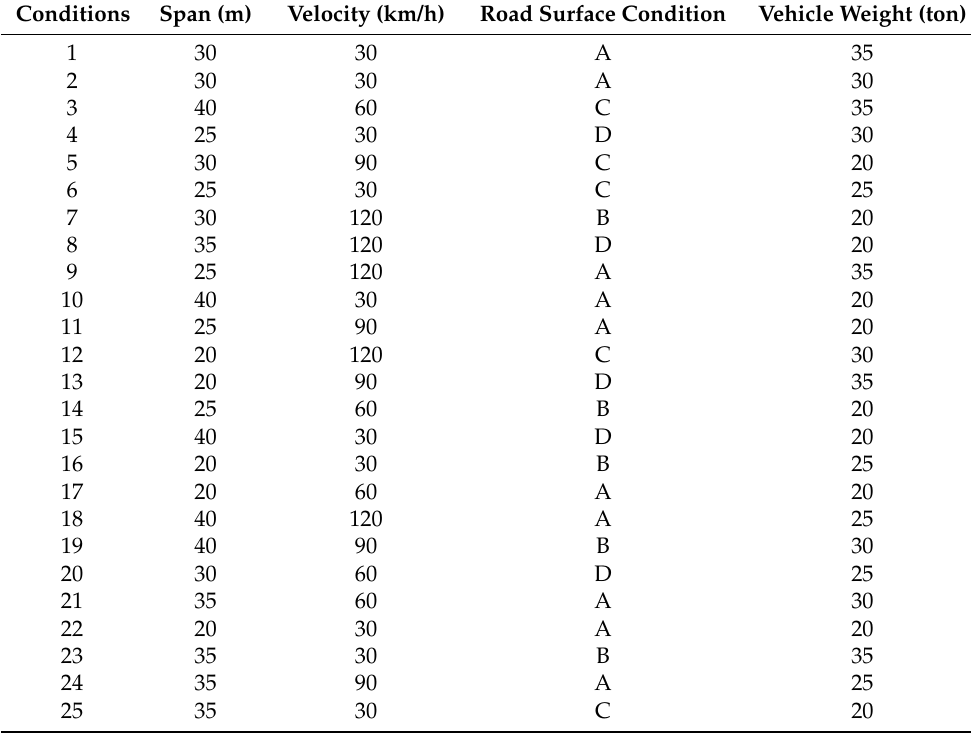
Figure 12. Time-history curves of the negative bending moment in the three-span continuous girder bridges. ( a ) Time-history curves of the bridges with a span of 20 m; ( b ) Time-history curves of the bridges with a span of 25 m; ( c ) Time-history curves of the bridges with a span of 30 m; ( d ) Time- history curves of the bridges with a span of 35 m; ( e ) Time-history curves of the bridges with a span of 40 m.